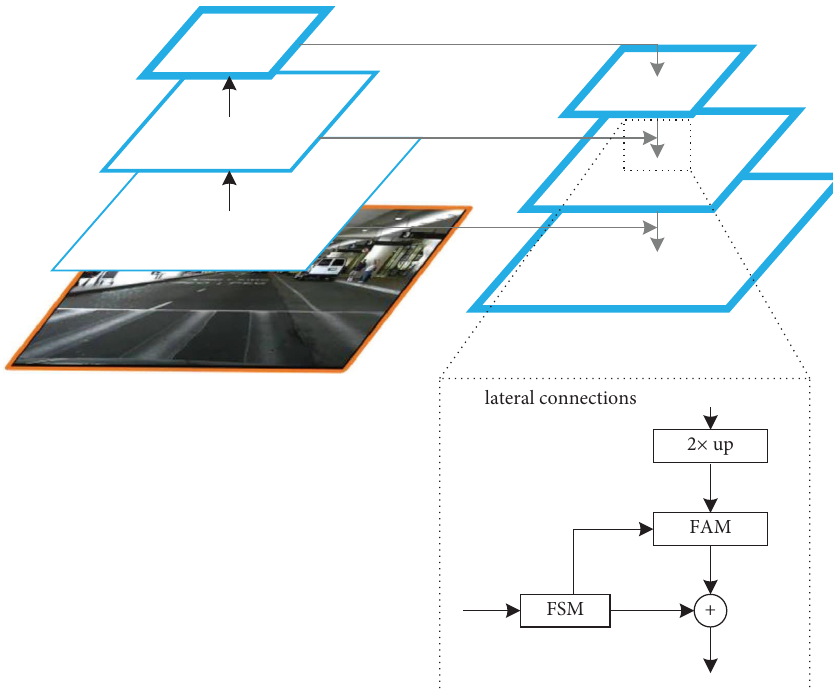
Figure 3: Improved feature pyramid